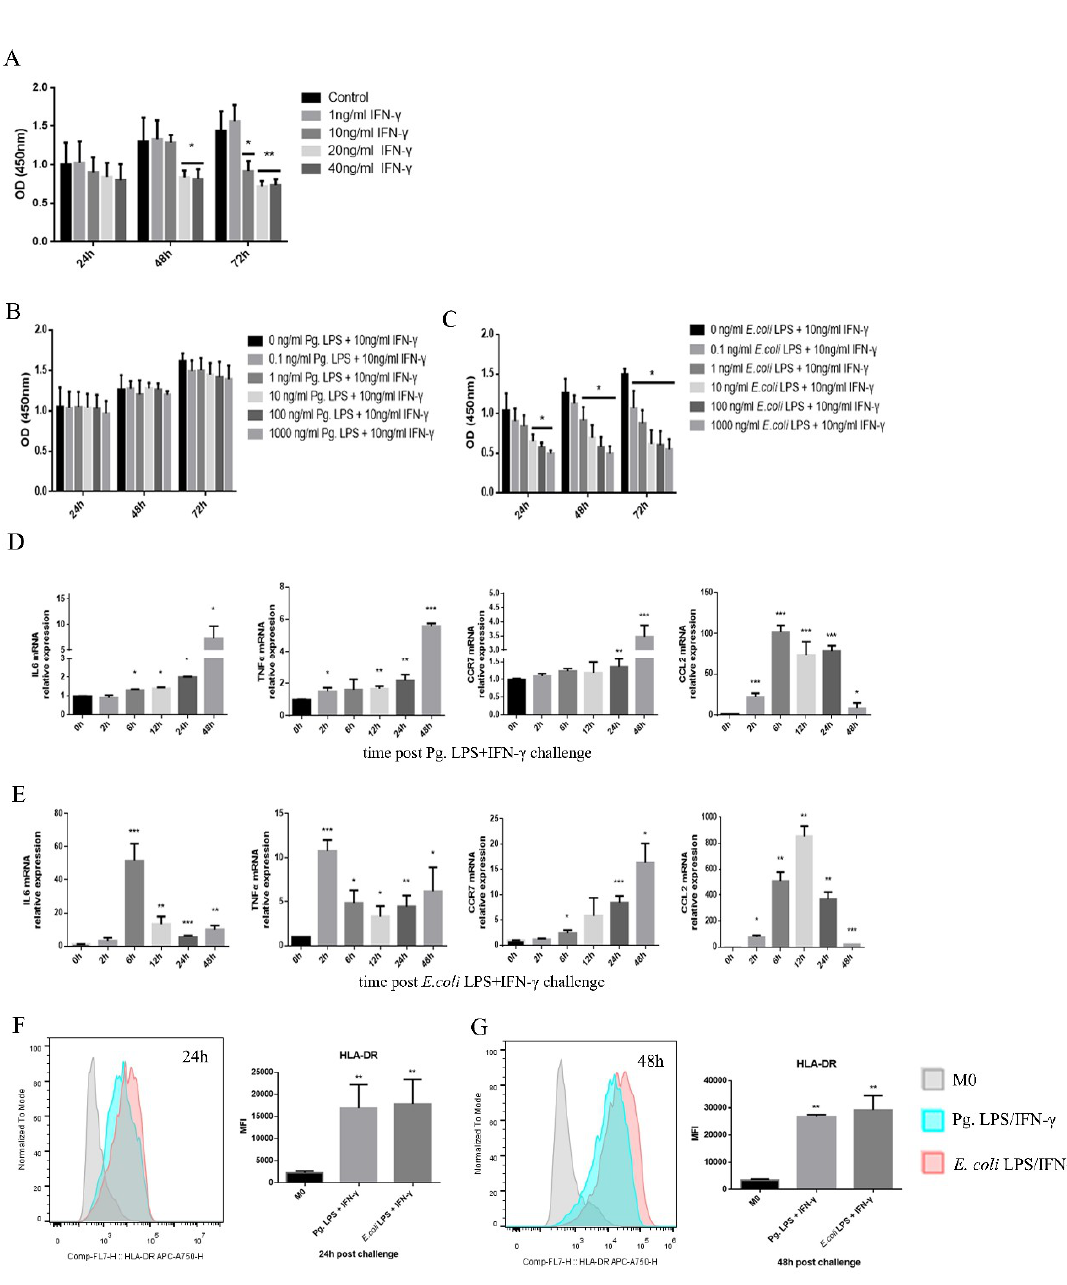
Figure 2. LPS/IFN-γ-induced M1 proinflammatory macrophage differentiation from M0 Figure 2. LPS / IFN- γ -induced M1 proinflammatory macrophage di ff erentiation from M0 macrophages. macrophages. ( A–C ) The effects of IFN-γ ( A ), Pg. LPS/IFN-γ, ( B ) and E. coli LPS/IFN-γ ( C ) on the ( A – C ) The e ff ects of IFN- γ ( A ), Pg. LPS / IFN- γ , ( B ) and E. coli LPS / IFN- γ ( C ) on the proliferation of proliferation of THP-1-derived macrophages were assessed. The cell growth of each group was THP-1-derived macrophages were assessed. The cell growth of each group was measured by a CCK8 measured by a CCK8 assay. ( D,E ) The mRNA expression of IL-6 , TNF-α , CCR7 , and CCL2 was assay. ( D , E ) The mRNA expression of IL-6 , TNF- α , CCR7 , and CCL2 was measured by qRT-PCR in cells measured by qRT-PCR in cells after stimulation with Pg. LPS/IFN-γ ( D ) or E. coli LPS/IFN-γ ( E ) for after stimulation with Pg. LPS / IFN- γ ( D ) or E. coli LPS / IFN- γ ( E ) for 2, 6, 12, 24, and 48 h. GAPDH was 2, 6, 12, 24, and 48 h. GAPDH was used as an internal control. ( F,G ) The expression of HLA-DR in used as an internal control. ( F , G ) The expression of HLA-DR in macrophages was analyzed by flow macrophages was analyzed by flow cytometry. M0 macrophages were used as a control. All of the cytometry. M0 macrophages were used as a control. All of the results represent the mean ± standard results represent the mean ± standard deviation of three independent experiments ( n = 3). * p < 0.05, deviation of three independent experiments ( n = 3). * p < 0.05, ** p < 0.01, and *** p < 0.0001 represent ** p < 0.01, and *** p < 0.0001 represent significant differences compared with the control. significant di ff erences compared with the 2.2. TET1 Expression Decreased in LPS/IFN-γ-Induced M1 Macrophages